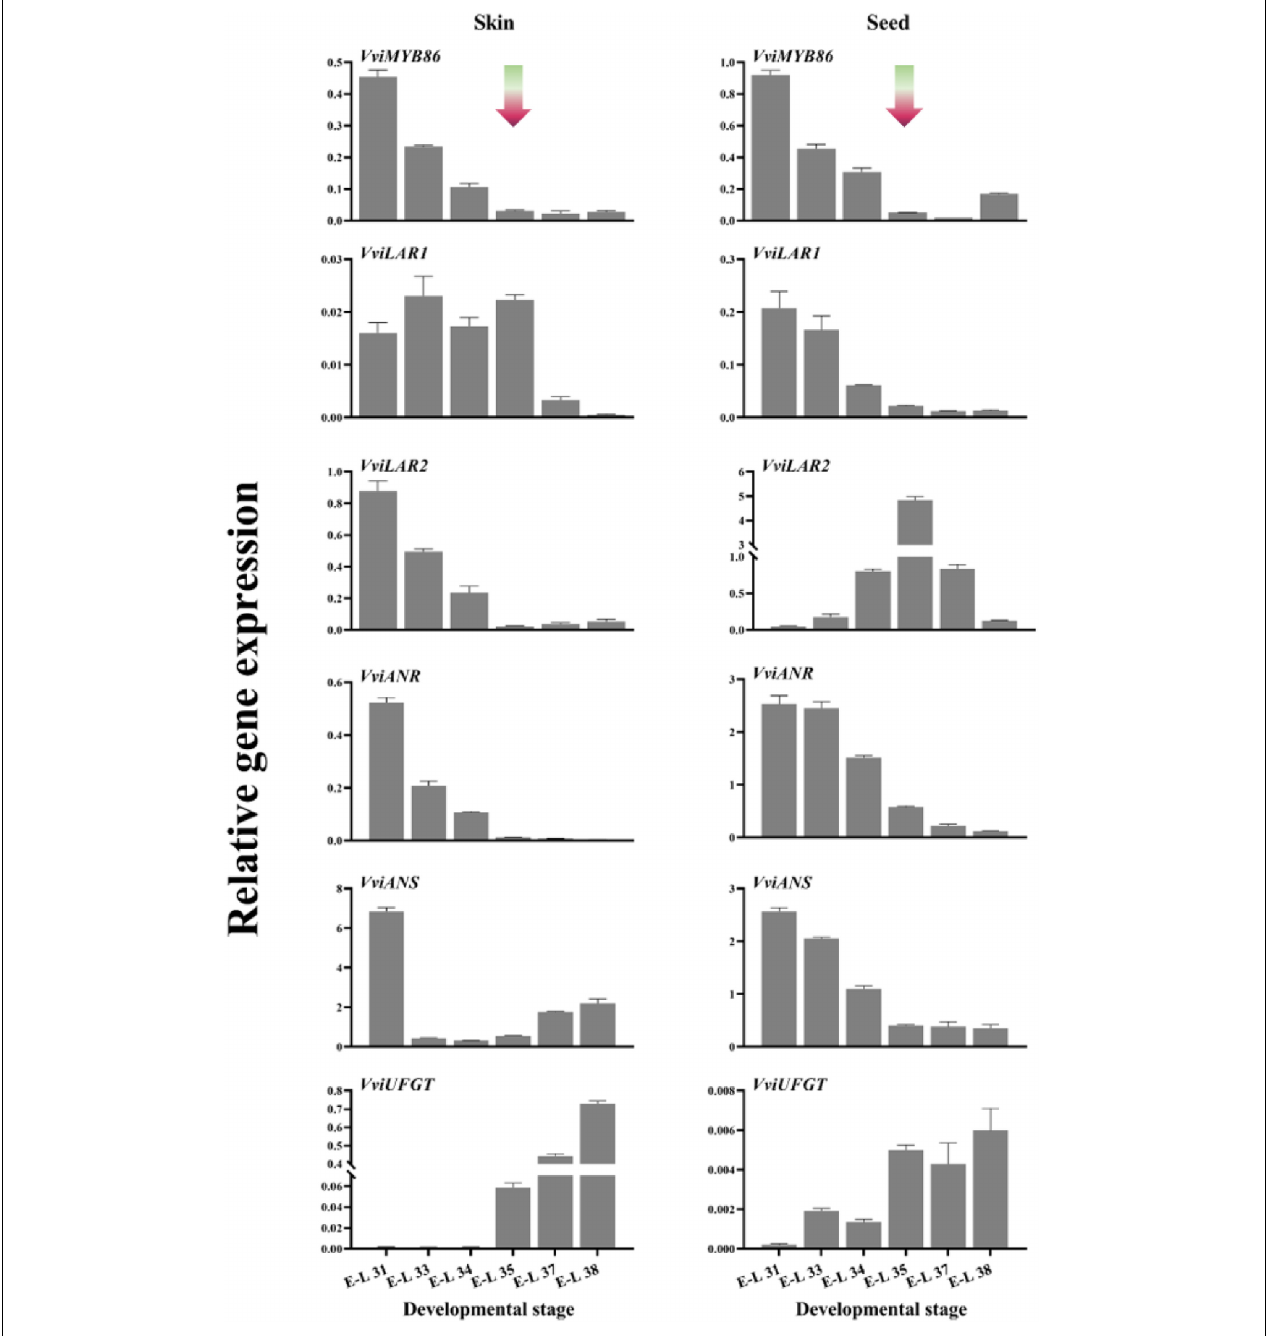
FIGURE 3 | Spatiotemporal expression profile of VviMYB86 and some PA-related and anthocyanin-related genes in grape skins and seeds. The gradient arrows indicated the time-point of véraison. Gene expression was determined by real-time quantitative PCR and normalized with the expression of VviUbiquitin1 . Each sample was individually assayed in triplicate. Error bars indicated the standard error of the